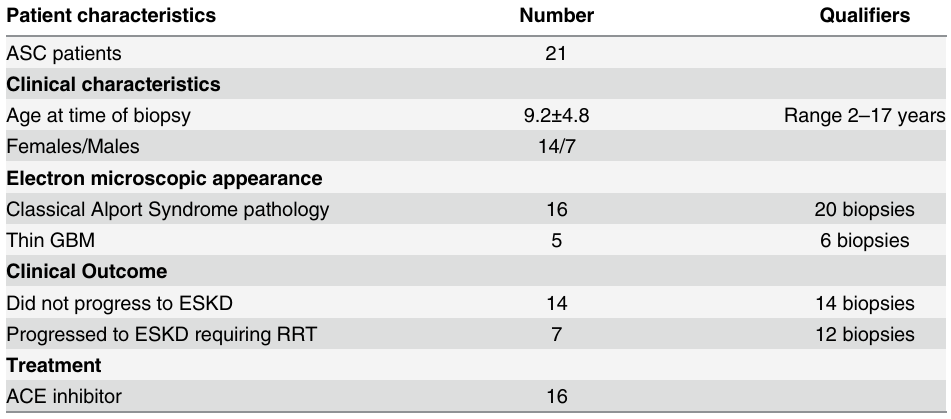
Table 1. ASC cohort characteristics at time of biopsy and treatment/outcome data. The deceased donor controls (n = 17) came from age 4 – 17 years deceased kidney donors with females/males = 12/5 similar to the ASC patient set